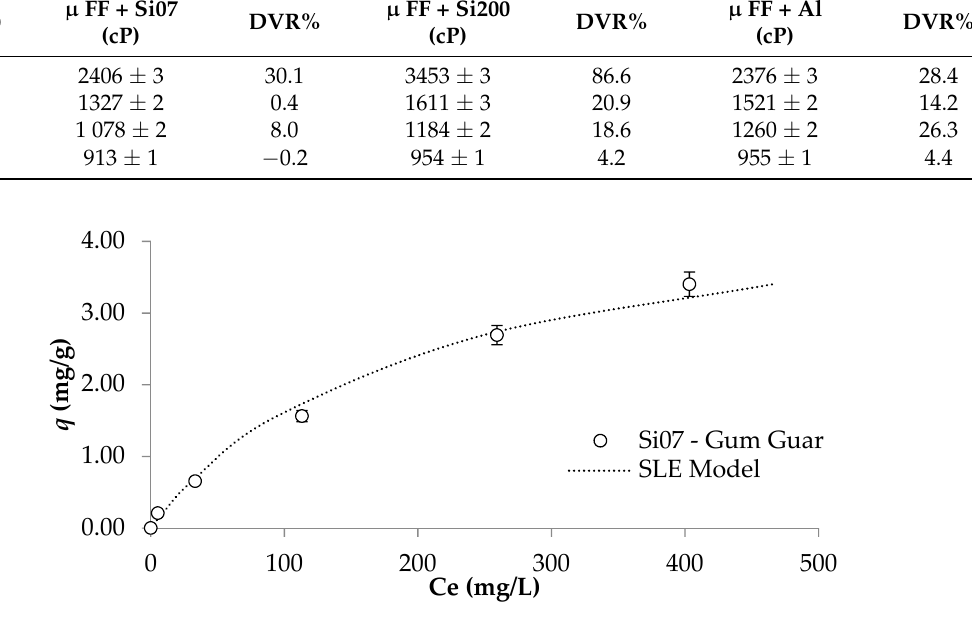
Figure 8. Adsorption isotherm of guar gum polymer onto Si07 nanoparticles at 1000 mg/L at a temperature of 25 ◦ C and atmospheric pressure. Table 7. Parameters estimated from the SLE model for guar gum polymer onto Si07 nanoparticles at 1000 mg/L at 25 °C and atmospheric pressure.